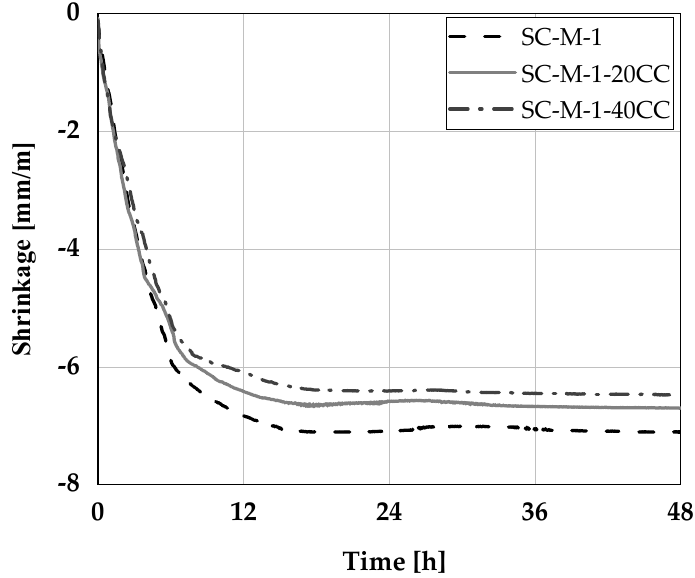
Figure 10. Plastic shrinkage of SC-M specimens.